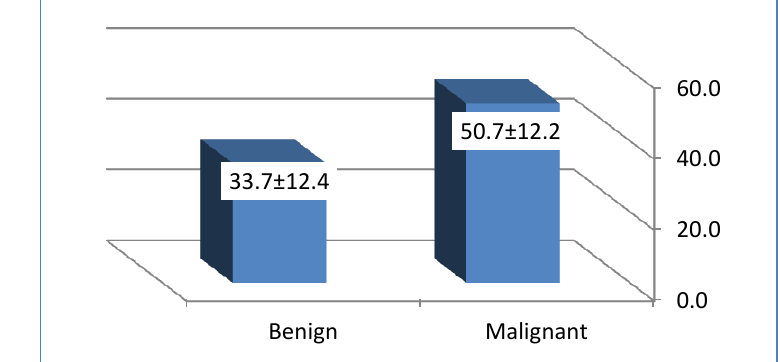
Figure 1 The mean age of study groups The age distribution of cases show that all of patients aged >70 years 10(100%) was malignant, followed by 60-69 years 11(78.6%). The malignant tumor also presented at earlier age group 20-29 years 2(5%) and 30-39 years 16(38.1%), this relation was statistically significant as shown in table